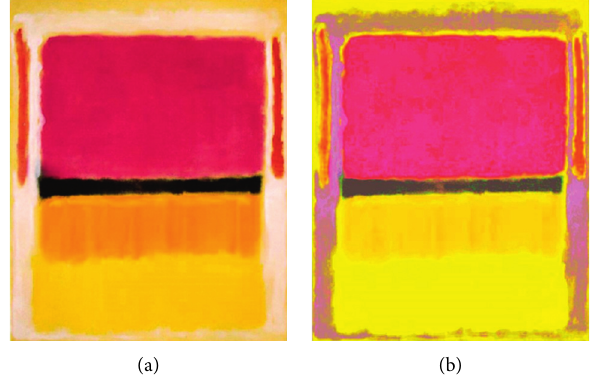
Figure 5: Color palette application over Mark Rothko’s Violet, Black, Orange, Yellow on White and Red